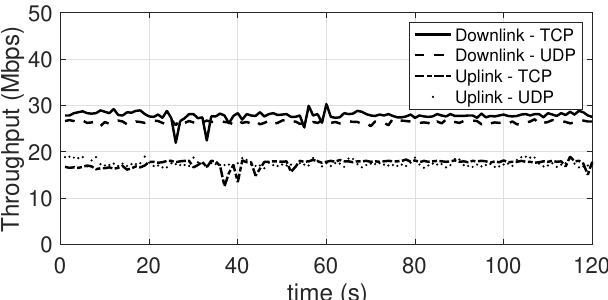
Figure 6. Single user performance. Downlink and Uplink with both TCP and